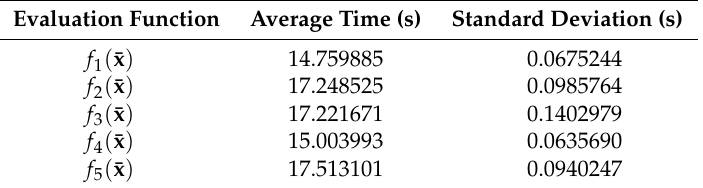
Table 6. Processing time for different evaluation